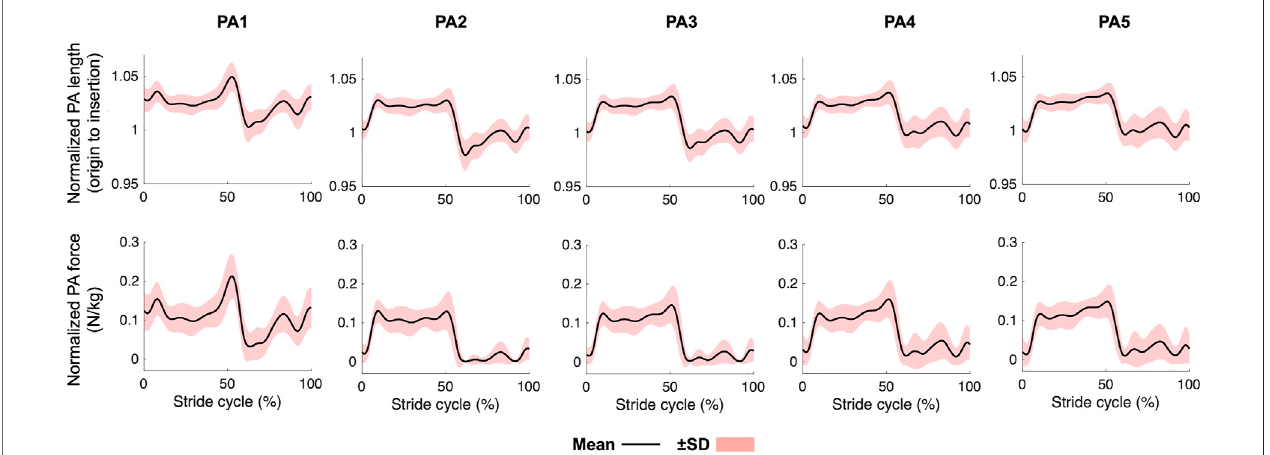
FIGURE 4 | Mean plantar aponeurosis length and force pro fi les during walking. Mean (solid line) ± standard deviation (red band).